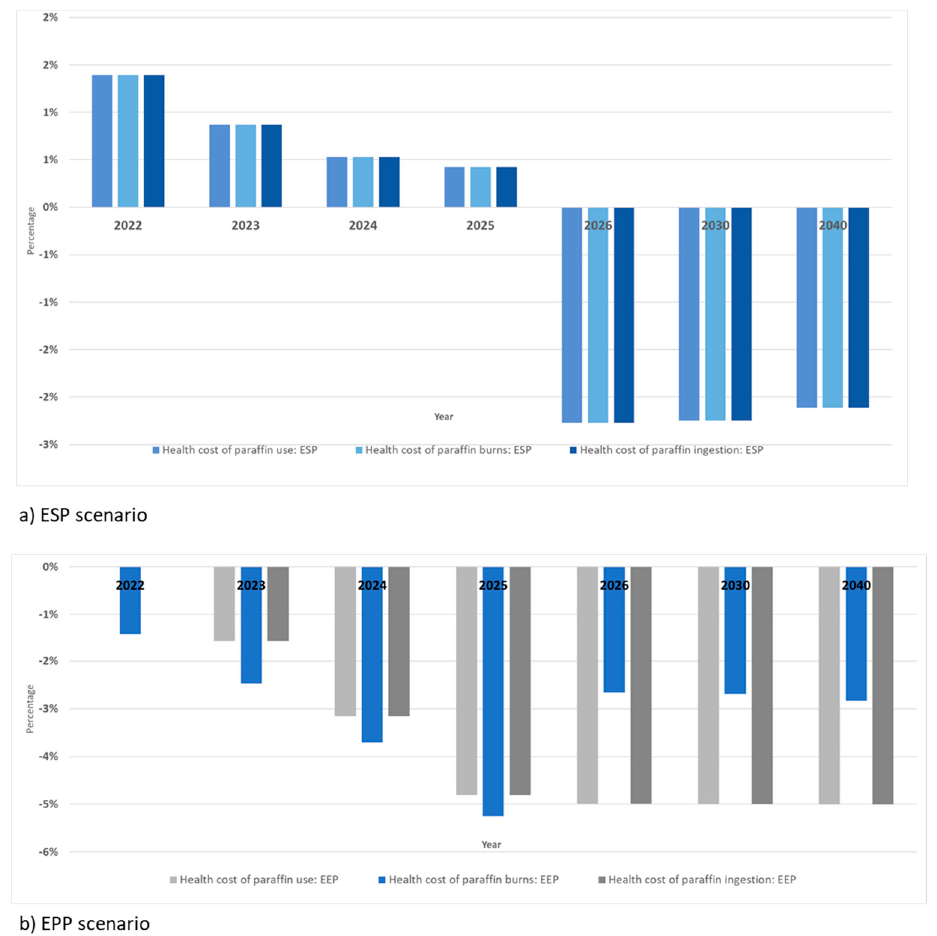
Figure 10. Percentage change in health costs of paraffin fuel, ESP ( a ) and EPP ( b ) scenarios. Source: Authors.